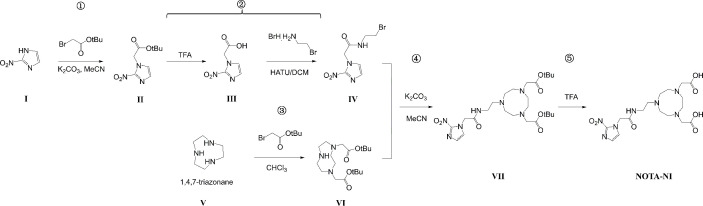
Synthesis pathways of NOTA-NI, a 2-nitroimidazole derivative.